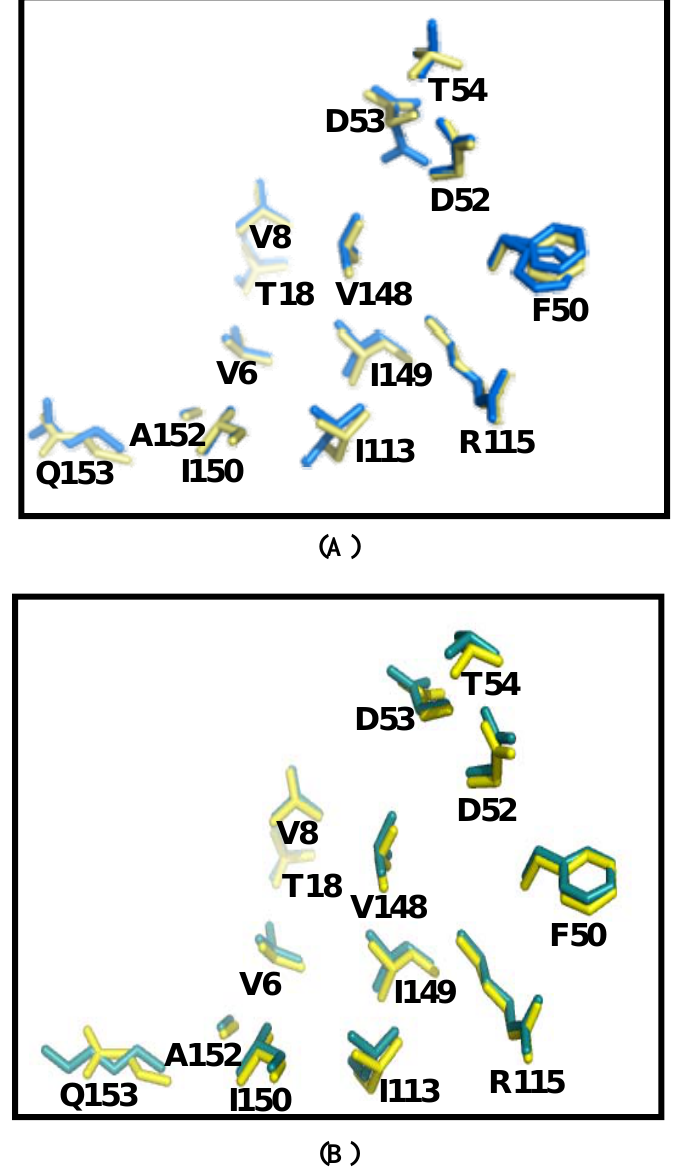
Figure 9. Comparison of the cSOD1 dimer forming residues of Camelus dromedarius (yellow) with Homo sapiens (blue) ( A ) and Bos taurus (deepteal) ( B ). The residues are numbered according to accession number JF758876. This comparison indicated very high similarity between the dimer interface of cSOD1 and that of hSOD1 and